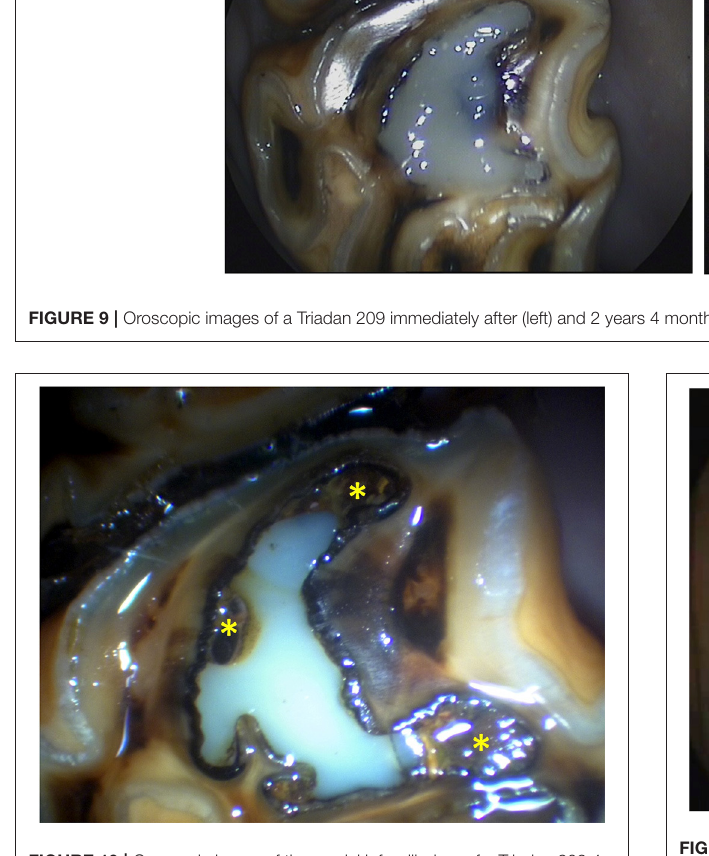
FIGURE 10 | Oroscopic image of the mesial infundibulum of a Triadan 209 4 years 3 months post-restoration of the mesial infundibulum, showing some defects in the restoration (*).